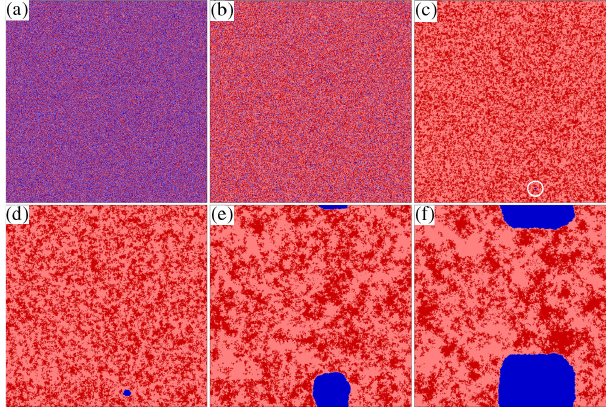
FIG. 3. Full β - γ phase diagram of the spatial public goods game with prosocial and antisocial punishment, as obtained for r ¼ 3 . 0 . Solid lines denote continuous phase transitions, while dashed lines denote discontinuous phase transitions. Representative spatial evolutions of the four competing strategies are presented in Figs. 4 – 6, while two representative cross sections of this phase diagram are presented in Fig. 7.